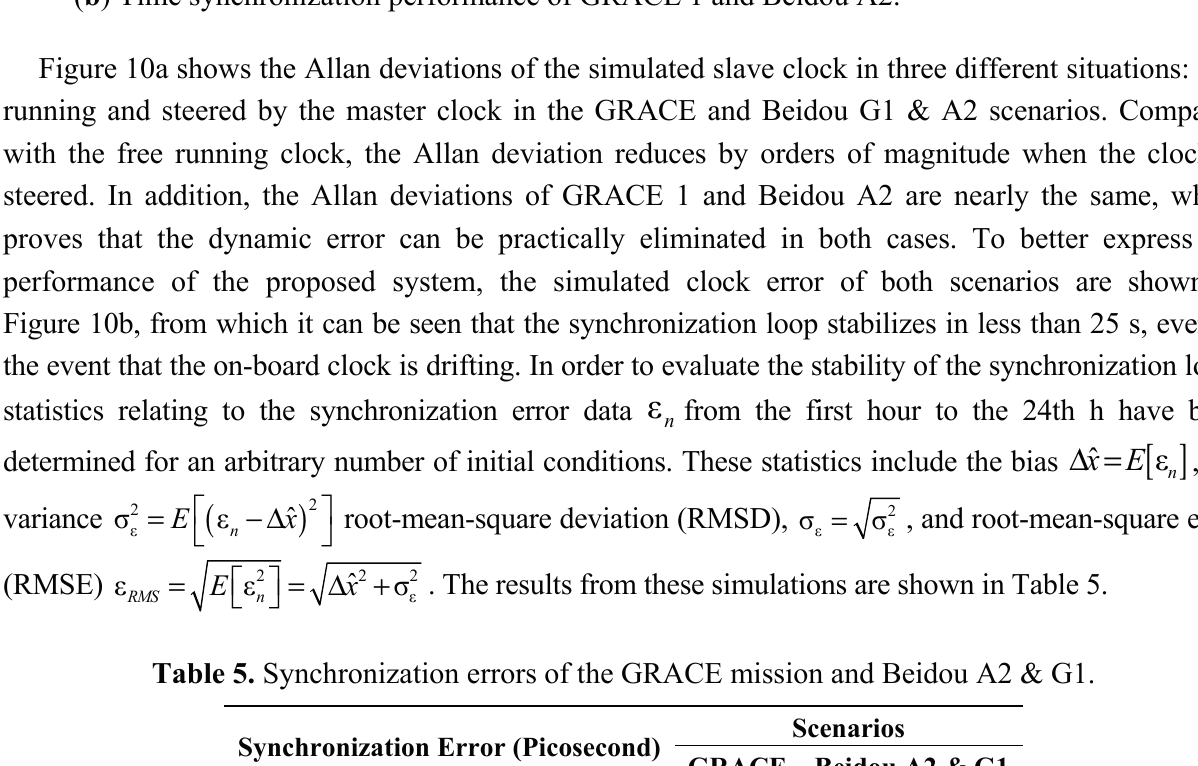
Figure 10. ( a ) Allan deviations of the simulated free running on-board VC-OCXO, and its Allan deviation in the provided scenarios when the synchronization loop stabilizes; ( b ) Time synchronization performance of GRACE 1 and Beidou A2.